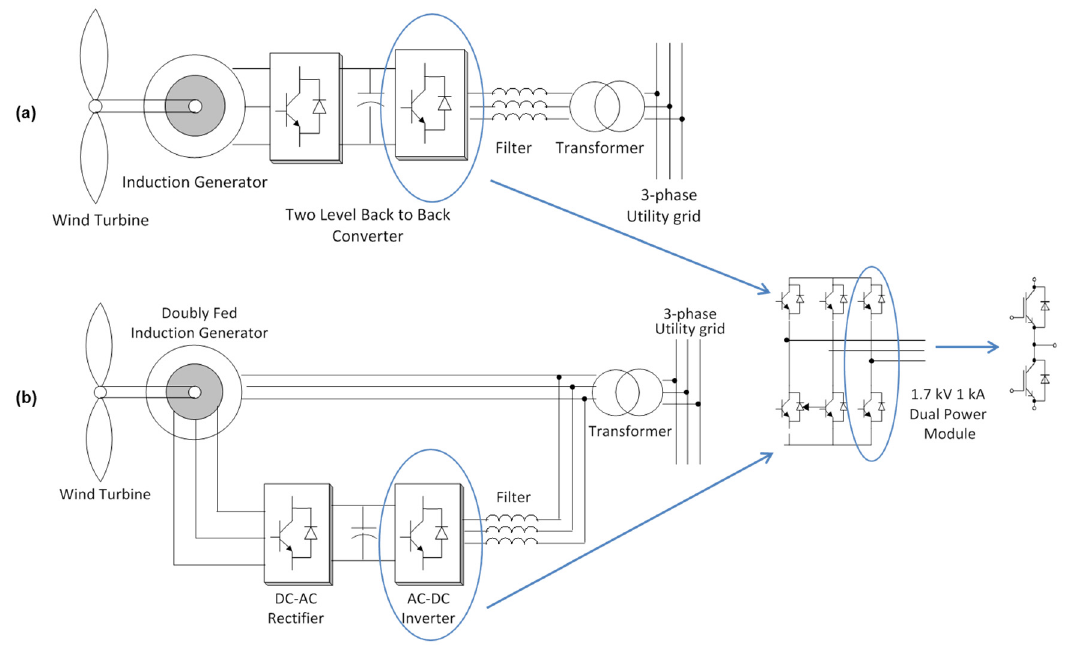
Figure 1. Two level back-to-back converter topology in ( a ) full scale (FS) and ( b ) partial scale (PS) based wind energy